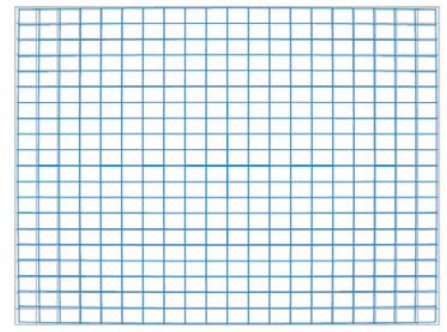
Figure 8. The calculated distortion grid.